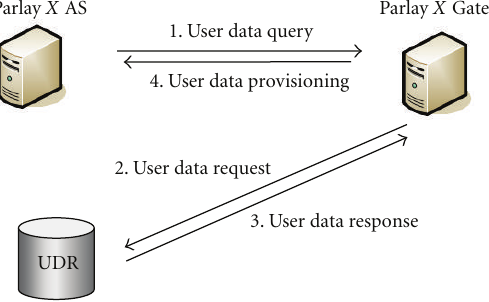
Figure 4: Open access to QoS-related user